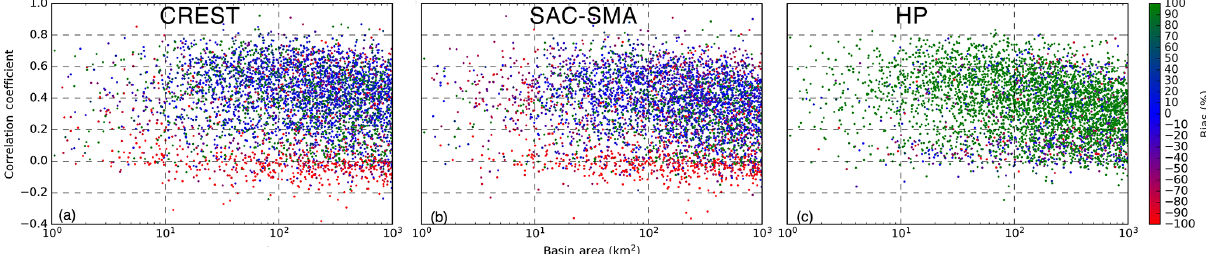
Figure 7. The correlation coefficient and normalized bias versus contributing drainage area for all gauges with drainage areas less than 1000km 2 for (a) CREST, (b) SAC-SMA, and (c) HP